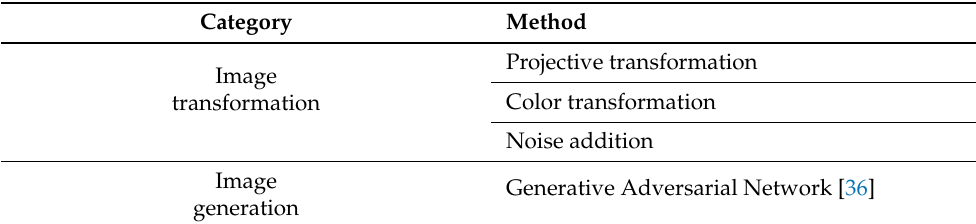
Table 1. Methods of image data augmentation